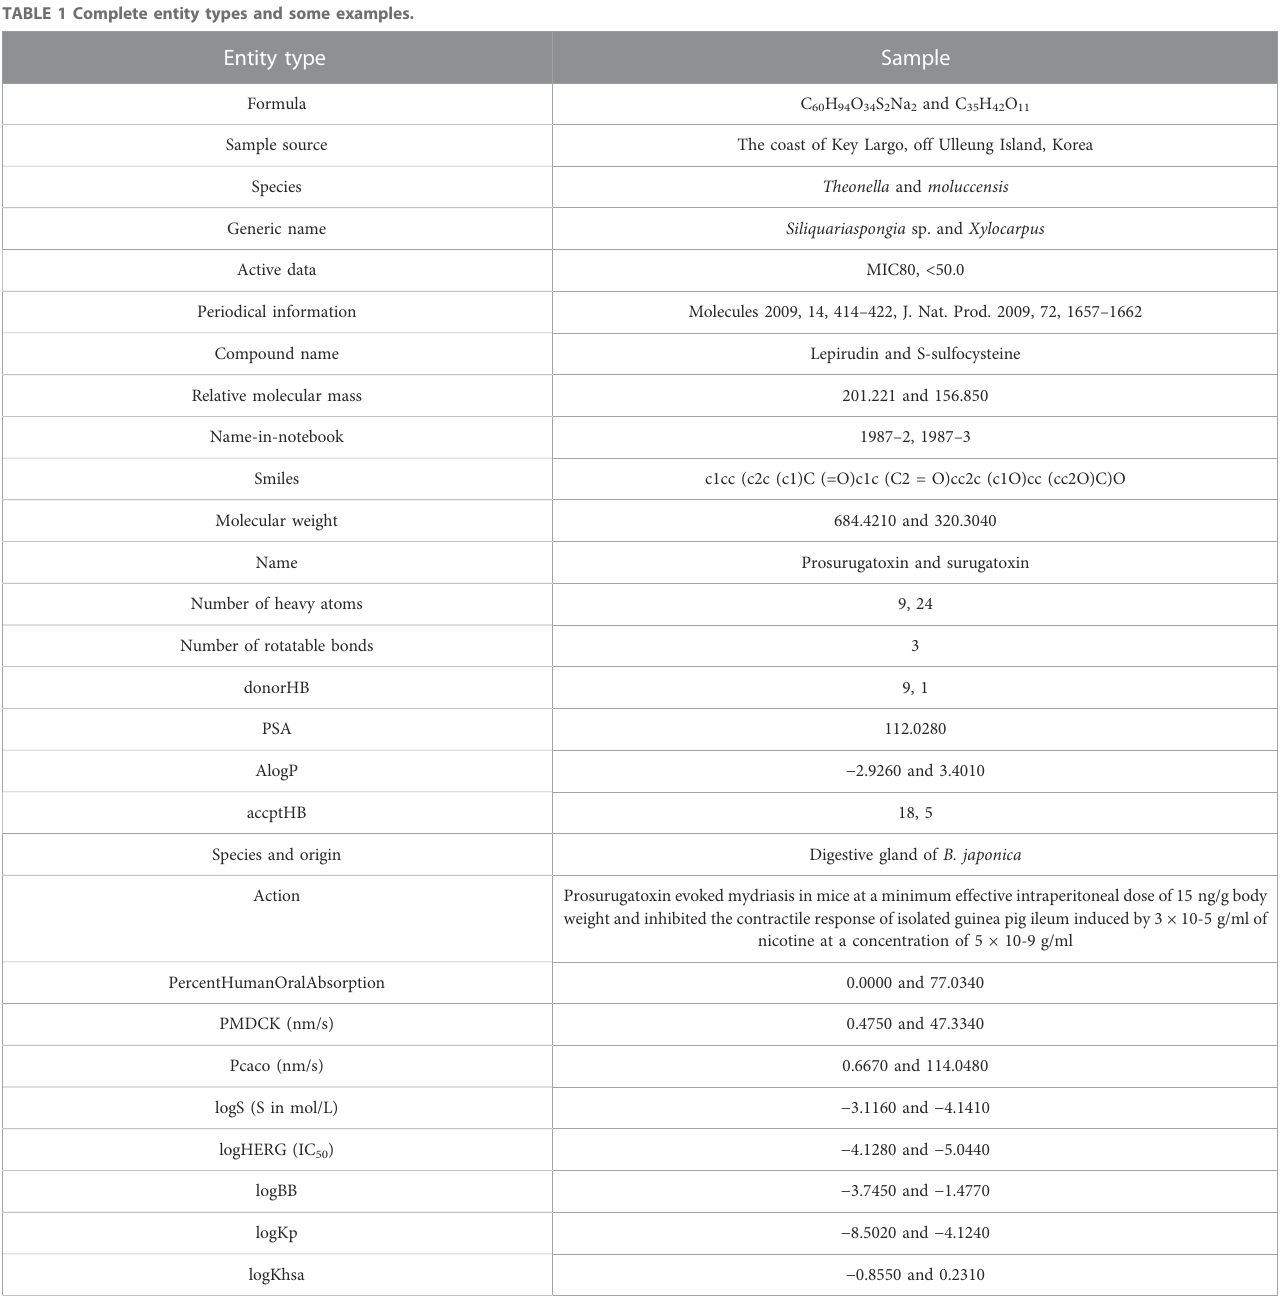
TABLE 1 Complete entity types and some